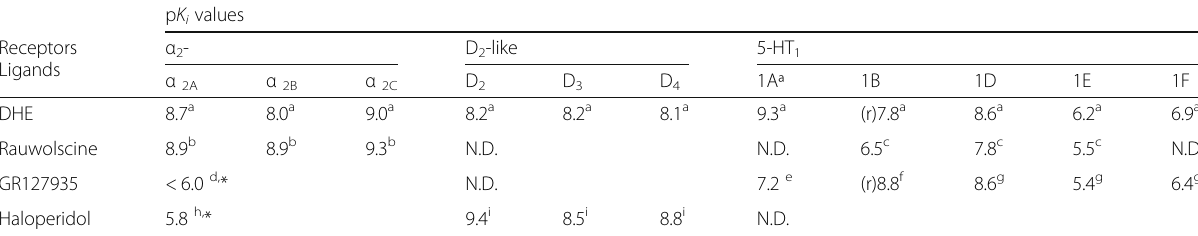
Table 1 Binding affinity constants (p K i ) for the α 2 -adrenergic, dopamine D 2 -like or serotonin 5-HT 1 receptor families and their respective receptor subtypes for dihydroergotamine (DHE), rauwolscine, GR127935 and haloperidol for cloned human receptors (unless otherwise stated) p K i values α Receptors 2 - Ligands